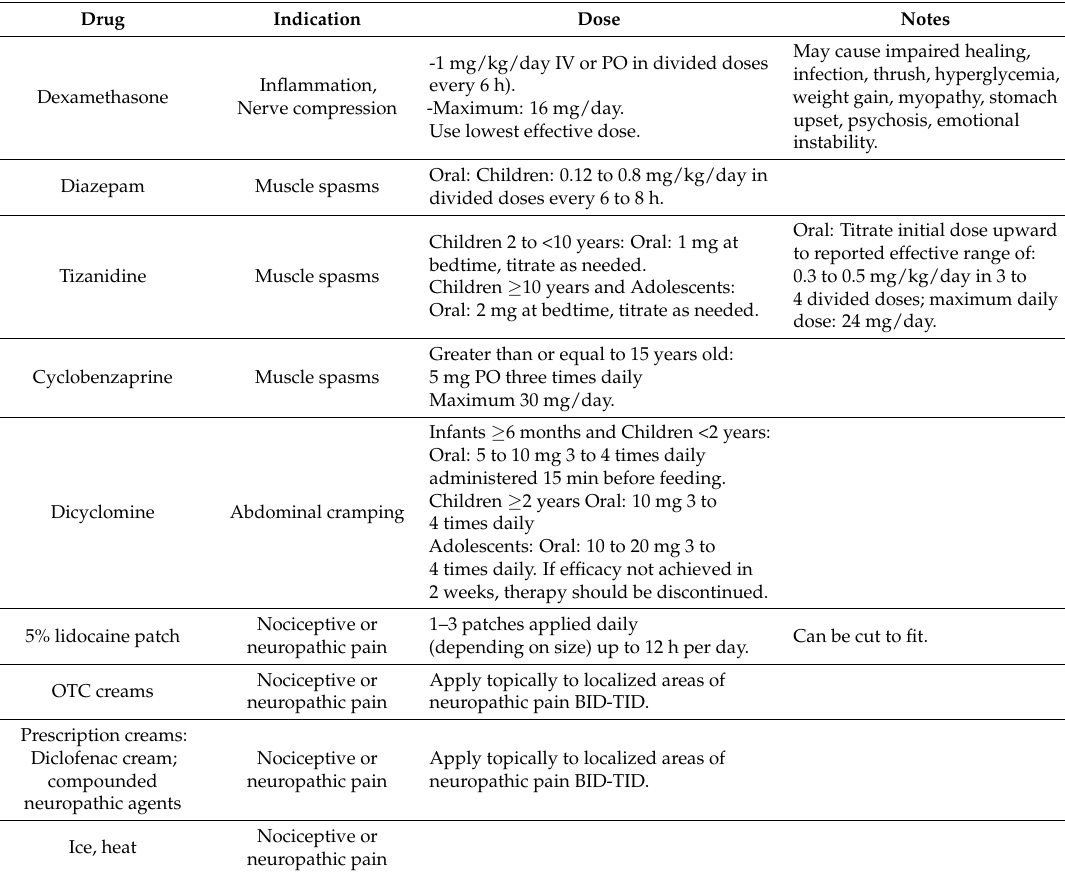
Table 7. Adjuvant pain